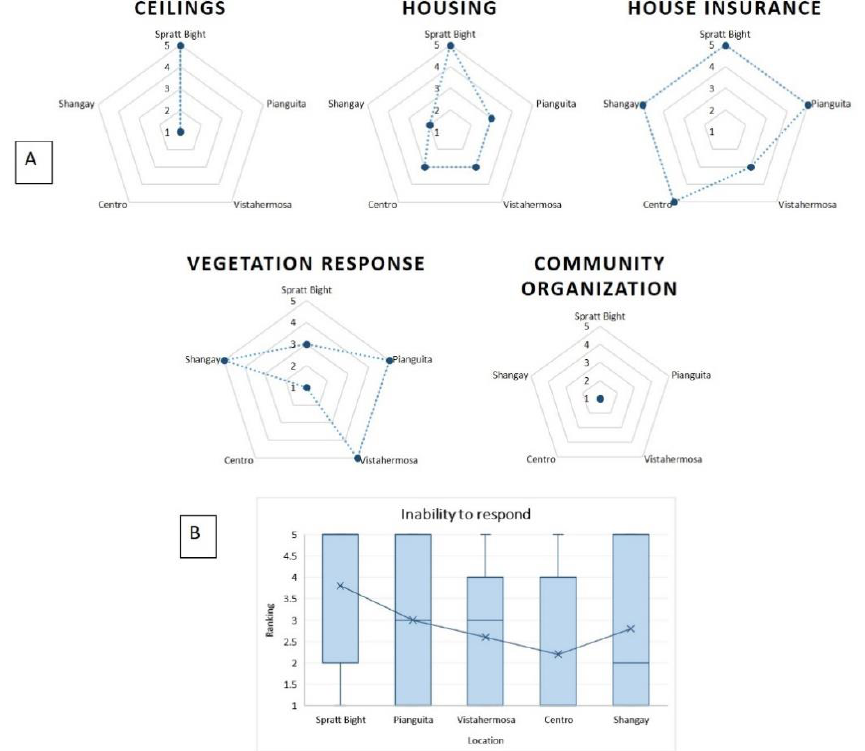
Figure 16. ( A ) Ranking of four variables representing inability to respond for two study areas (and five villages): San Andrés, Caribbean Coast (Spratt Bight) and La Bocana, Pacific Coast (Pianguita, Vistahermosa, Centro, Shangay) of Colombia. ( B ) Minimum and maximum values of inability to respond for each village and average rank. Results are shown by ranking, given that units of analysis are rank levels and not segments, as was the case for hazard.